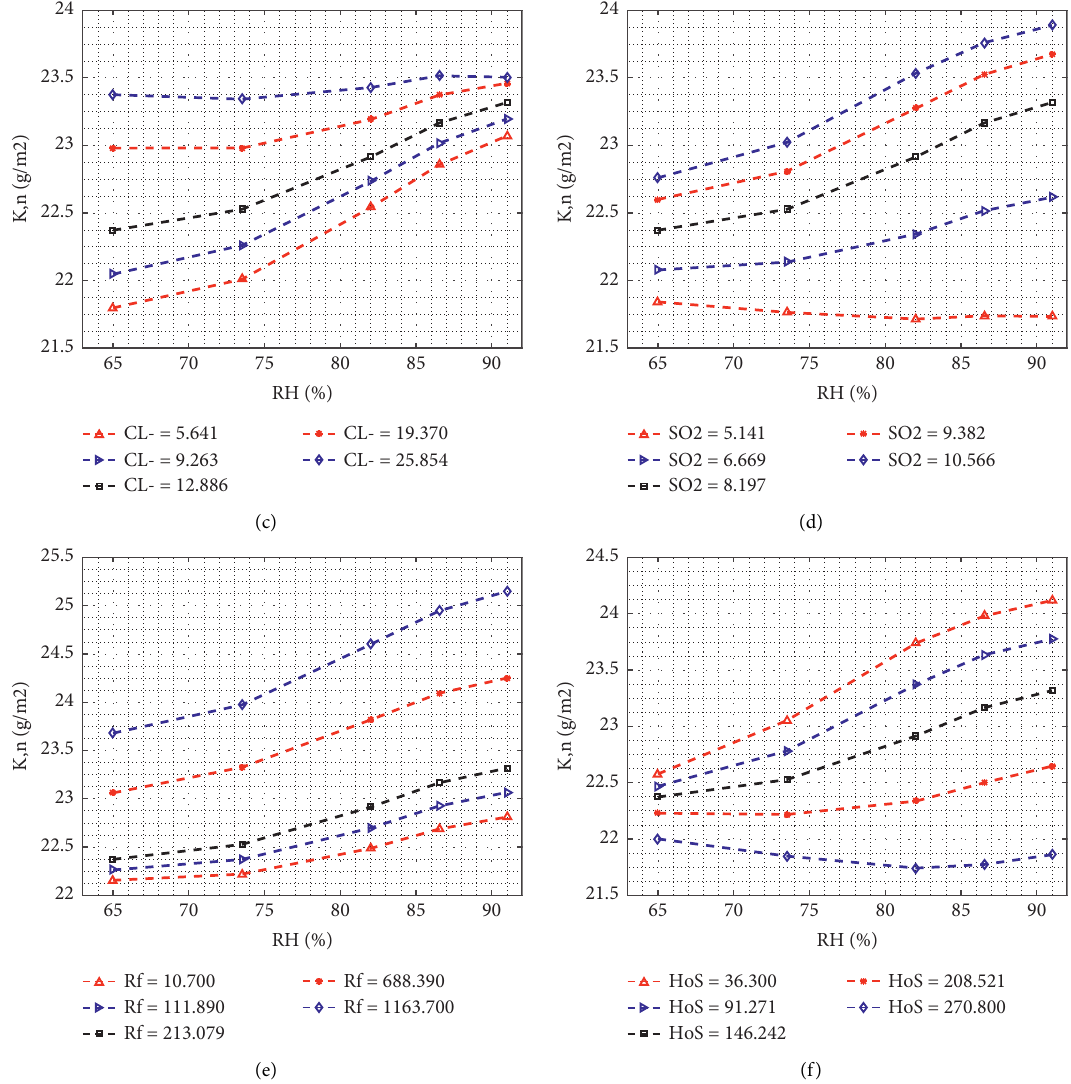
Figure 14: Effect of the average relative